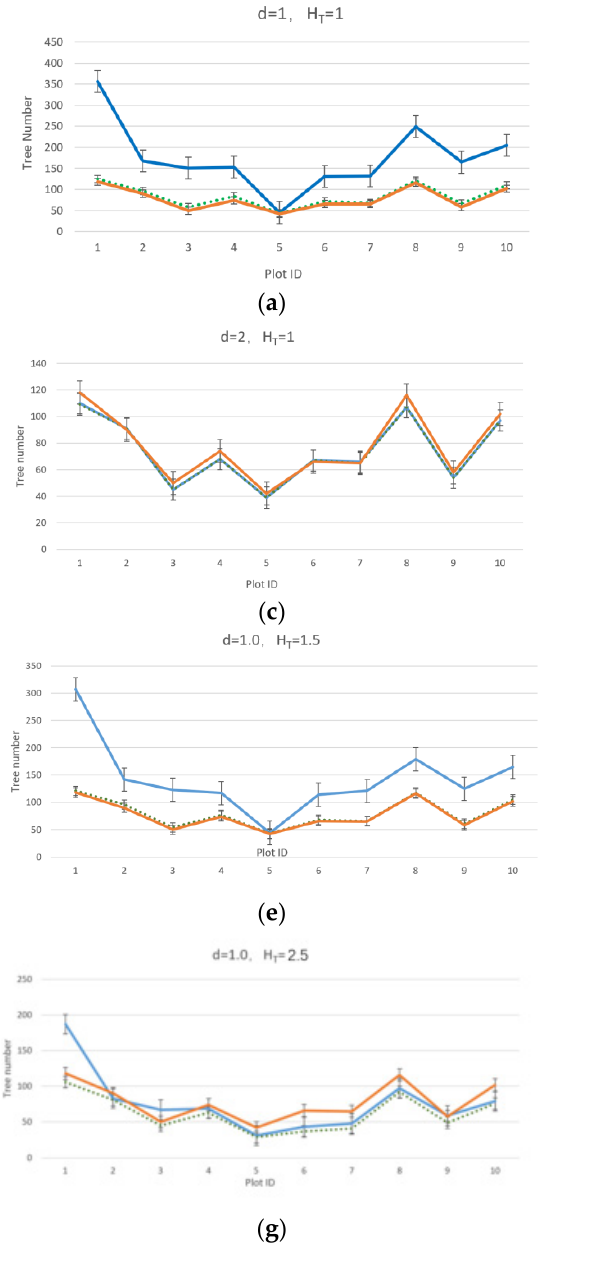
Figure 16. The rough tree number and calculated tree number in each plot with different values of parameters d and H T . The blue curve represents rough tree numbers of each plot, the green dashed line represents the final calculated tree number obtained from the RPAA and the orange curve represents the true tree numbers measured on the sample plots.(1) The segmented tree number when d = 1 m and H T = 1 m.(2) The segmented tree number when d = 2 m and H T = 1 m.(3) The segmented tree number when d = 2 m and H T = 1 m. (4) The segmented tree number when d = 2.5 m and H T = 1 m.(5) The segmented tree number when d = 1 m and H T = 1.5 m. (6) The segmented tree number when d = 1 m and H T = 2.0 m. (7) The segmented tree number when d = 1 m and H T = 2.5 m. Table 3. The rough tree number and calculated tree number in each plot with different values of parameters d and H T.